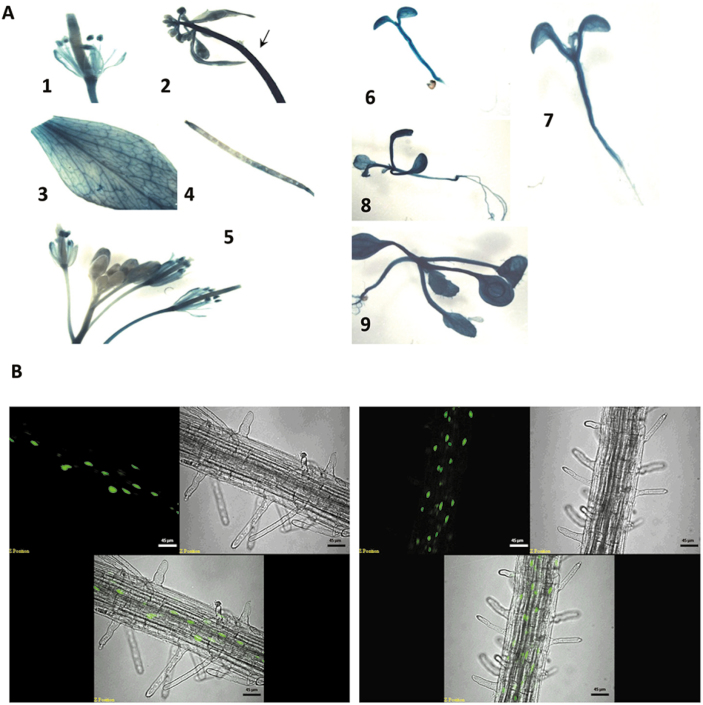
Gene expression and subcellular localization of SHI2. (A) GUS staining showing the expression of the SHI2 promoter–GUS at different developmental stages and in different organs. 1, Flower; 2, hypocotyl; 3, leaf; 4, silique; 5, meristem/flower; 6, 3-day-old seedling; 7, 7-day-old seedling; 8, 10-day-old seedling; 9, 14-day-old seedling. (B) Confocal images showing the subcellular localization of the SHI2–GFP fusion protein. Scale bars=45 μm. (This figure is available in color at JXB online.)